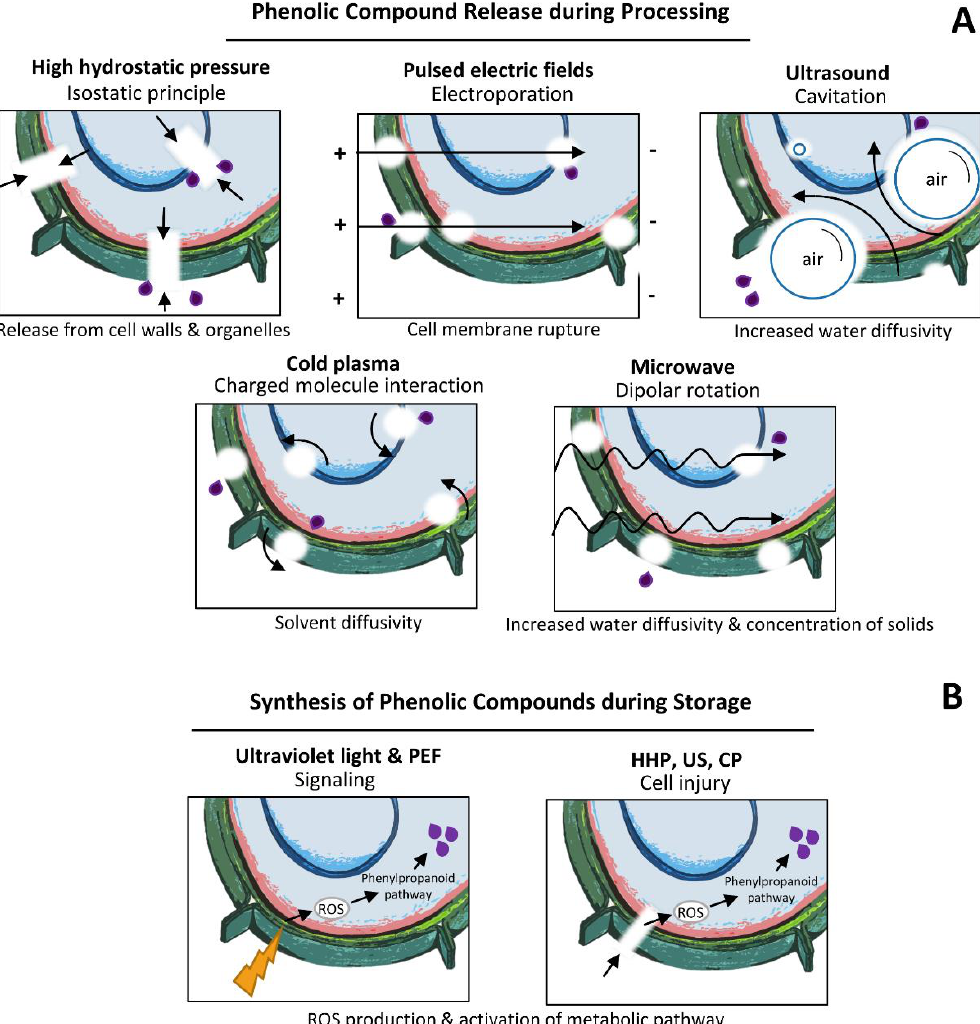
Figure 1. Mechanisms that drive increases in phenolic compound content in fruits treated with innovative technologies: ( A ) increases in the extractability of phenolic compounds and ( B ) synthesis of phenolic compounds during storage. Purple drops = phenolic compounds.